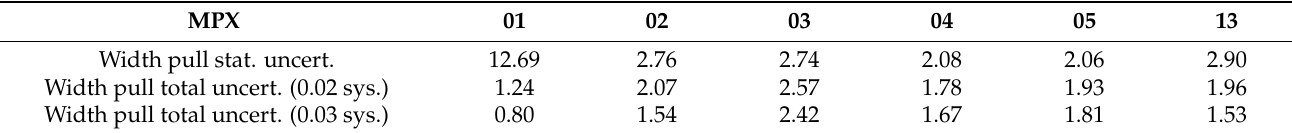
Table 11. Widths of the Gaussian fits to the pull distributions for MPX01-05 and MPX13. The widths are given for (cid:112) N hit / N cl for each MPX device, given in Table 5. The uncertainties resulting from the number of hits scaled by a factor widths are also given for statistical and systematic uncertainties added in quadrature, where the systematic uncertainties result from luminosity fluctuations not described by the fit function (taking 0.02 and 0.03). Table 10 indicates the sizes of the uncertainty applied. LHC fill 3249. Taken from Ref. [11]. MPX 01 02 03 04 05 13 Width pull stat. uncert. 12.69 2.76 2.74 2.08 2.06 2.90 Width pull total uncert. (0.02 sys.) 1.24 2.07 2.57 1.78 1.93 1.96 Width pull total uncert. (0.03